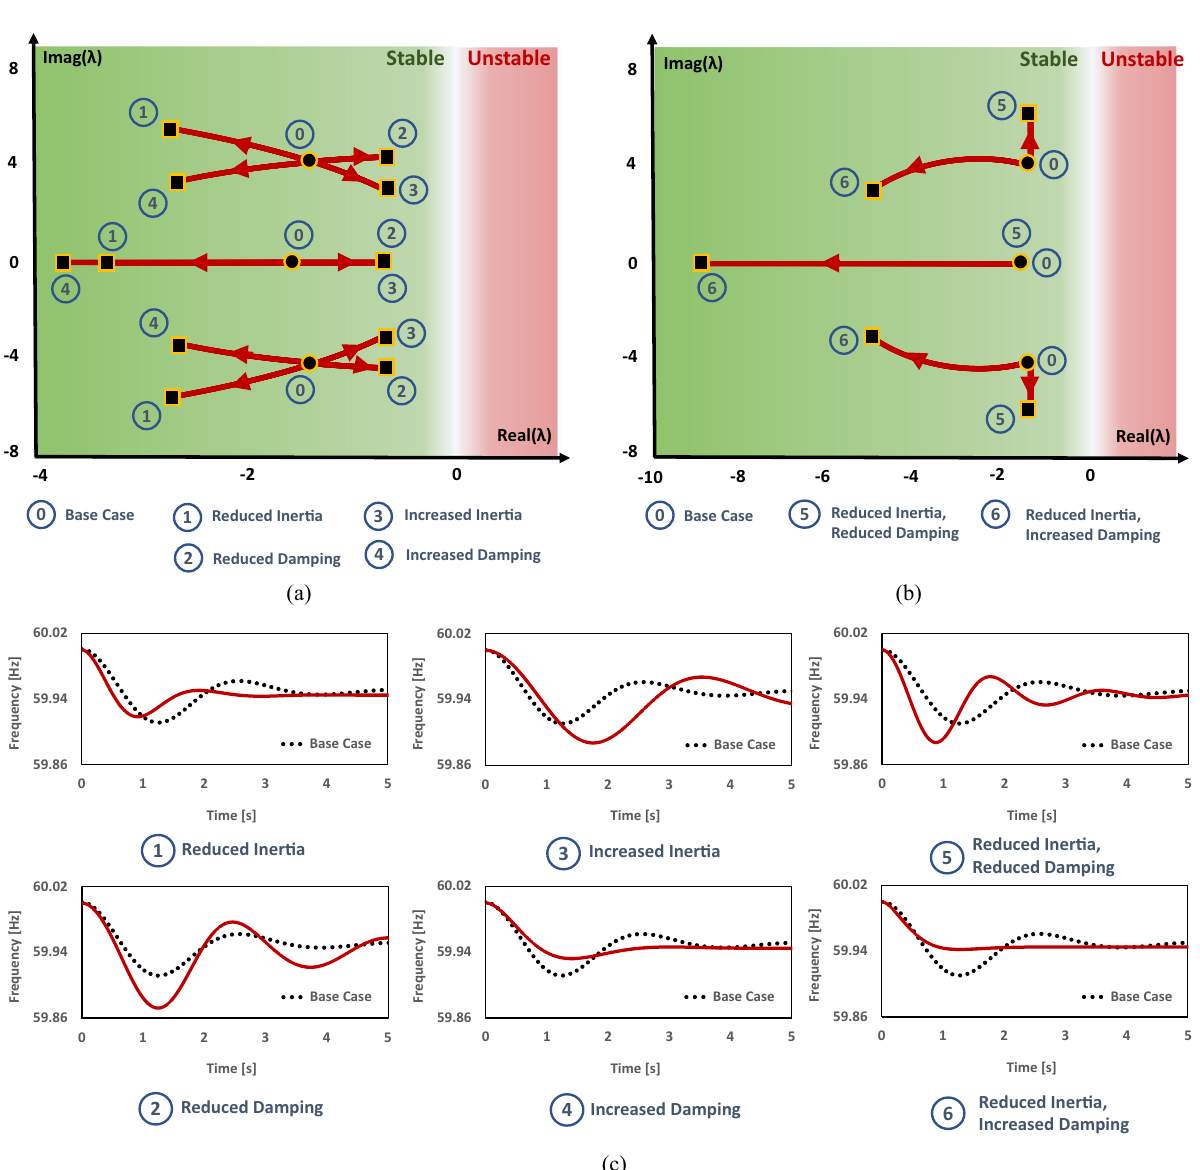
Fig. 3 Loci of migration of eigenvalues in the complex plane and time-domain response as generator parameters are varied. a Individual parameter changes, b concurrent parameter changes that replicated technological changes, c time-domain dynamic response. We analyzed the sensitivity of eigenvalues of a non-reference generator to parametric changes and the network coupling mode in the 3-generator network as a benchmark. For the base case, M i = (1.59, 0.80, 0.32) and D i = (1.53, 1.53, 0.92). For the network data see Supplementary Note 6. We considered six scenarios in addition to the base case. In each scenario, one or more parameters were changed by an order of 2. All plots shown include two internal modes that yield a pair of